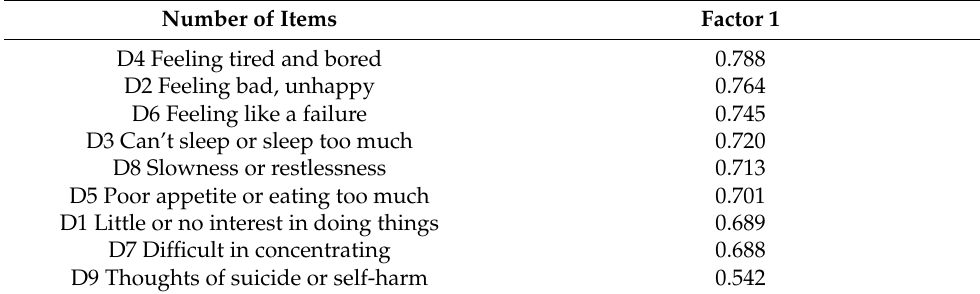
Table 2. The Patient Health Questionnaire with factor load